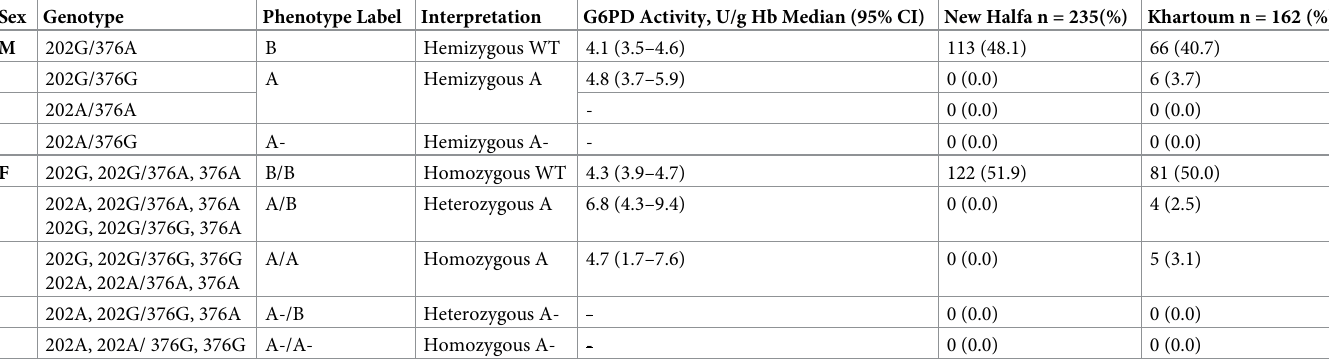
Table 5. Comparison of genotypic data by study site, Sudan (n = 397). (note: WT = wild type). Sex Genotype Phenotype Label